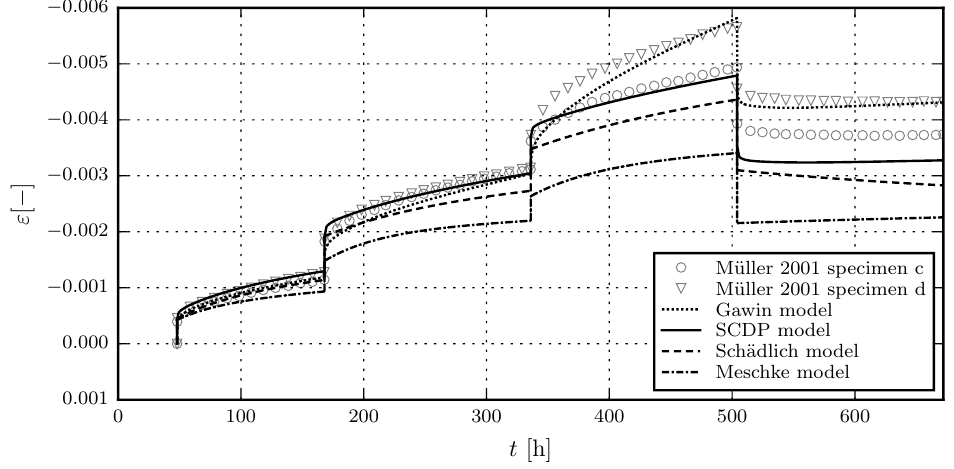
Figure 6. Evolution of the total strain in creep tests on unsealed specimens: Validation of the shotcrete models by means of the test data from creep test series 4/2 by Müller